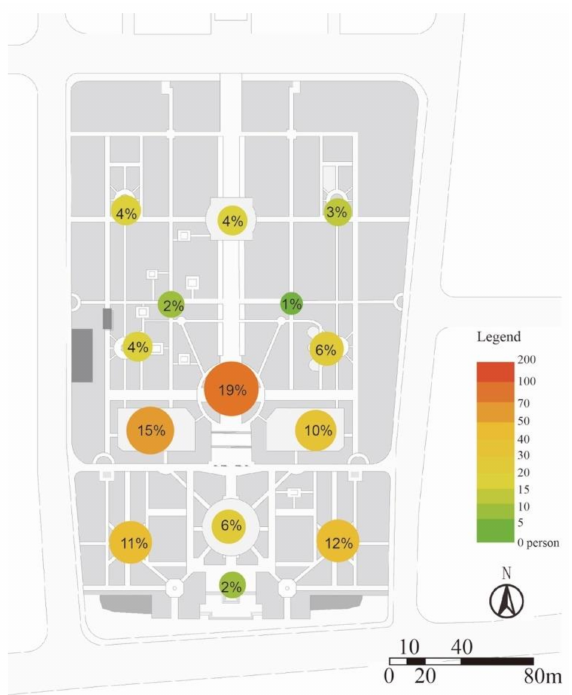
Figure A8. Spatial distribution of average total number of users per hour in Renmin